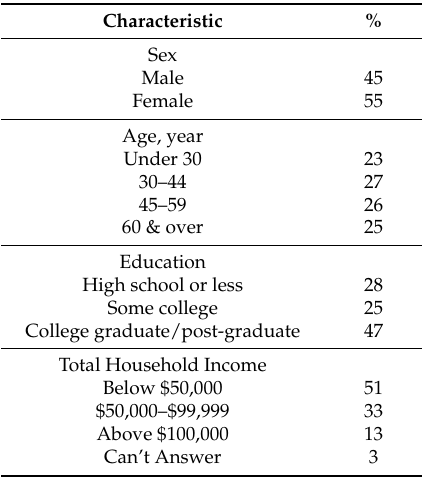
Table 1. Characteristics of Respondents ( N =